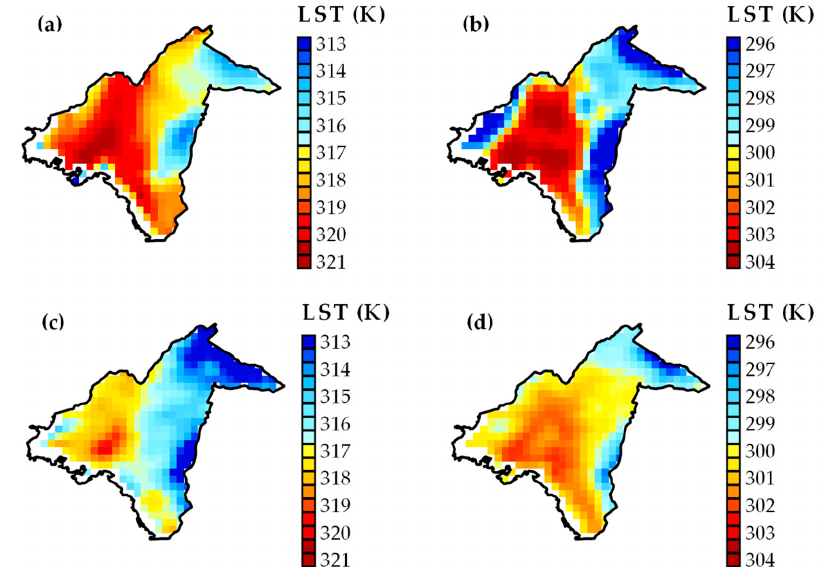
Figure 13. Spatial distribution of the modeled surface temperature in Athens using WRF ( T s ) and of